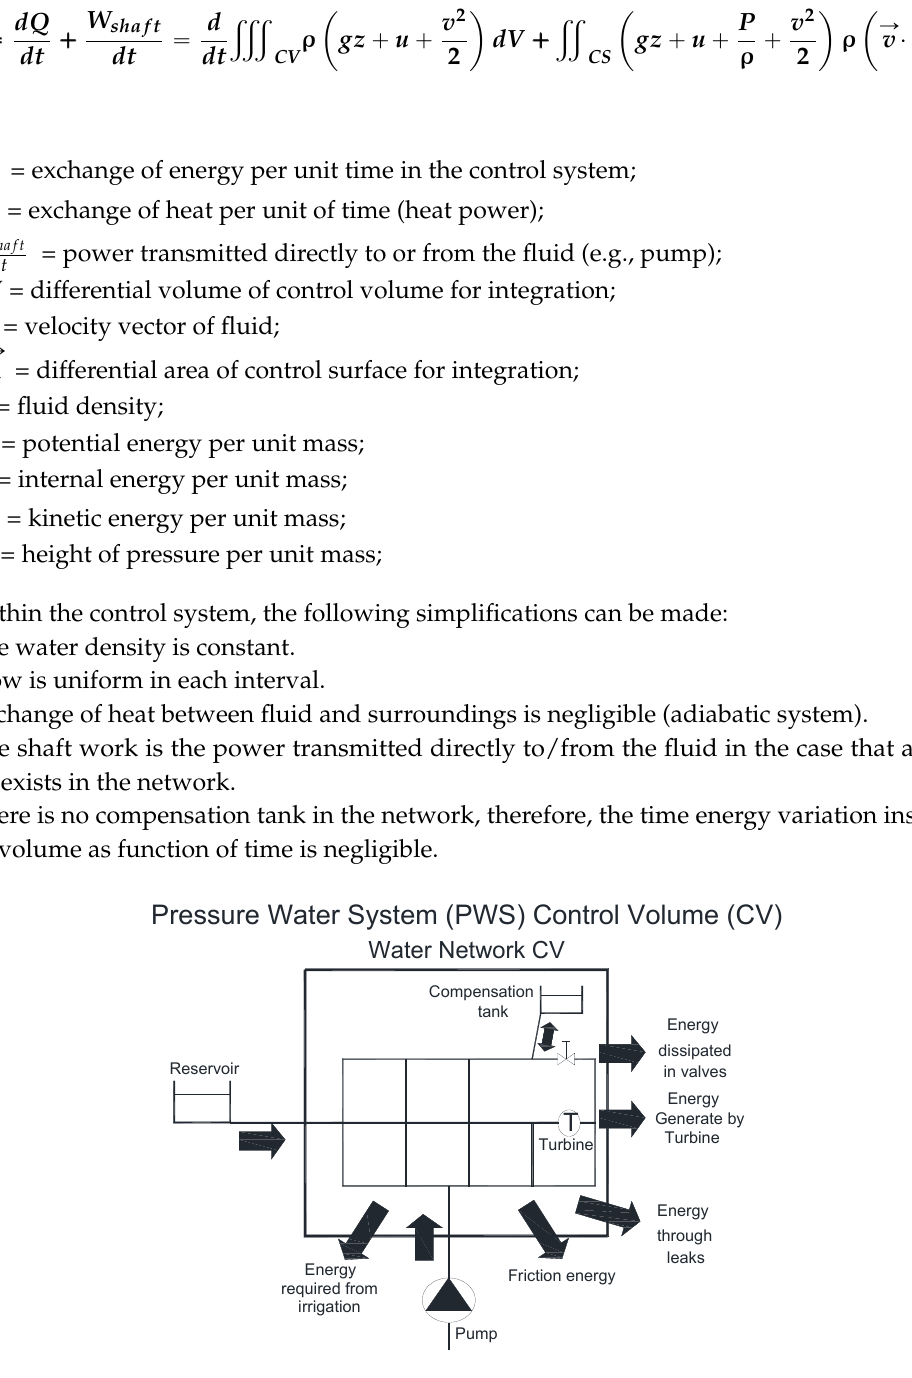
Figure 2. Energy balance in the pressurized irrigation water network adapted from [36].